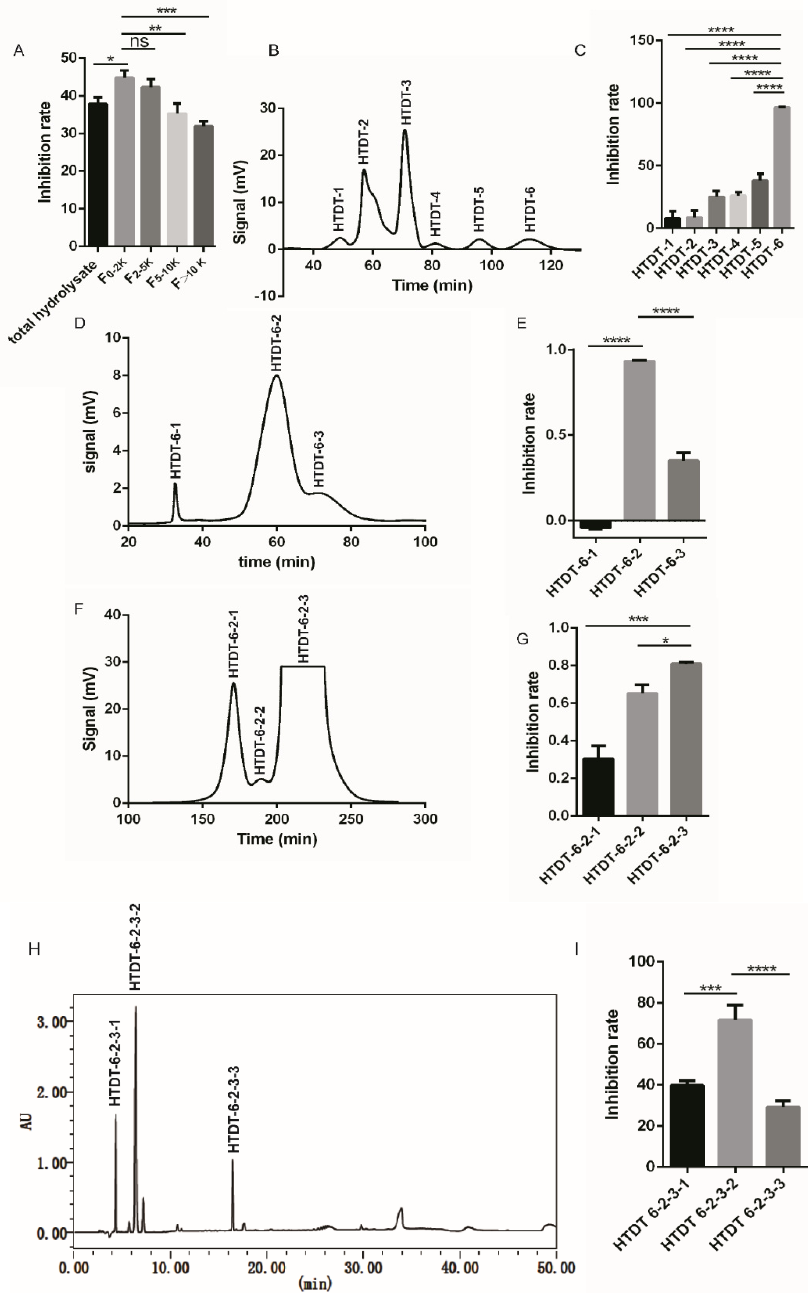
Figure 2. Purification of anticancer peptide by ultrafiltration and sequential chromatography. ( A ) After being fractionated by a series of tangential flow filtration units, peptide fractions with a molecular weight < 2 KDa (F 0-2K ) exhibit the most potent anti-proliferation activities. ( B ) The elution curve of F 0-2K by a 4 × 60 cm Sephadex LH-20 column using deionized water as the mobile phase. ( C ) Growth inhibition rate on NCI-H460 cells of the corresponding fractions shown in B. ( D ) The elution curve of HTDT-6 by 4 × 60 cm Sephadex LH-20 column using 20% ( v/v ) ethanol as mobile phase. ( E ) Growth inhibition rate of corresponding fractions showed in D. ( F ) The elution curve of HTDT-6-2 by a 1.5 × 170 cm Sephadex LH-20 column using 5% ( v/v ) ethanol as the mobile phase. ( G ) Growth inhibition rate of corresponding fractions showed in F. ( H ) HPLC profile of HTDT-6-2-3 separated by a Waters Atlantis T3 4.6 × 250 mm, 5 μ m column. ( I ) Growth inhibition rate of the corresponding fractions shown in H. * p < 0.05, ** p < 0.01, *** p < 0.001, **** p < 0.0001 and ns, not significant (n = 3).